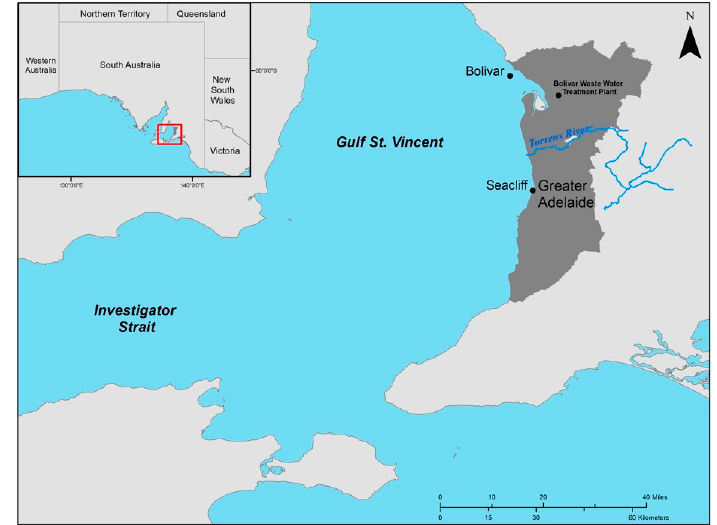
Figure 1. Sampling sites, Bolivar and Seacliff Sites, are north and south of metropolitan-Adelaide in Gulf St. Vincent, South Australia, with specific coordinates as 34°42 ′ 55.82 ″ S, 138°26 ′ 45.57 ″ E and 35°2 ′ 12.05 ″ S, 138°30 ′ 37.19 ″ E, respectively.